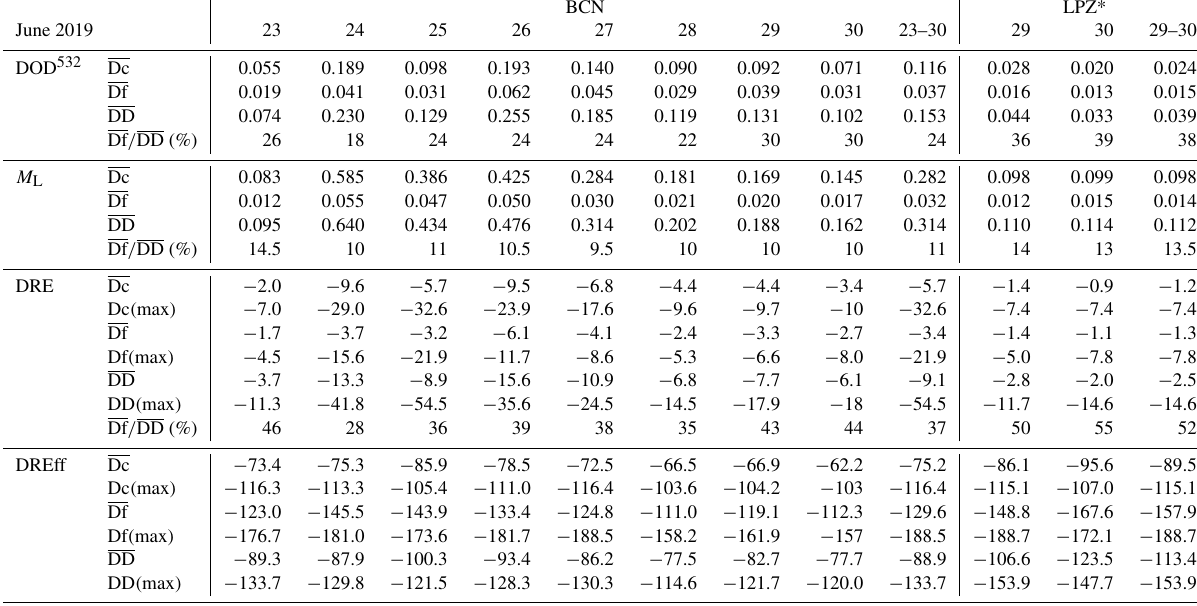
Table 4. DRE (Wm − 2 ) and DREff (Wm − 2 τ − 1 ) on the surface (SRF) as induced by Dc, Df, and DD particles along the particular dust periods in BCN and LPZ. X and X( max ) indicate daily averaged and maximal instantaneous values, respectively. The daily DOD at 532nm (DOD 532 ) and the mass loading ( M L , in gm − 2 ) are also included. Df / DD denotes the Df-to-total dust